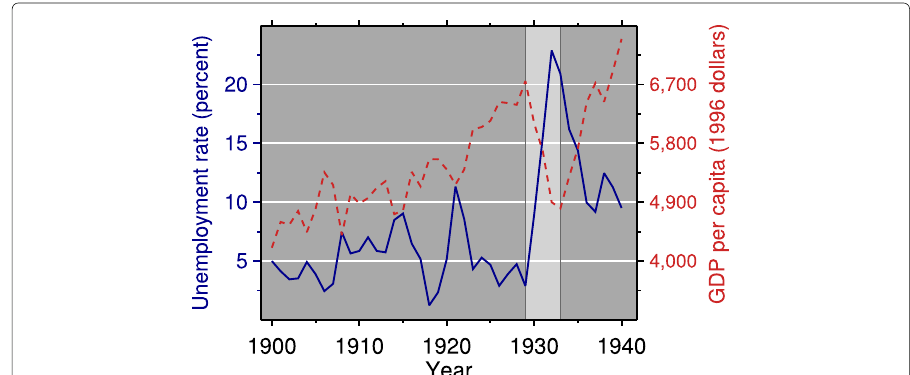
Fig. 1 Socioeconomic statistics, USA, 1900–1940. Unemployment rate (left y -axis), solid line. Per capita GDP (right y -axis) inflation-adjusted to 1996, dashed